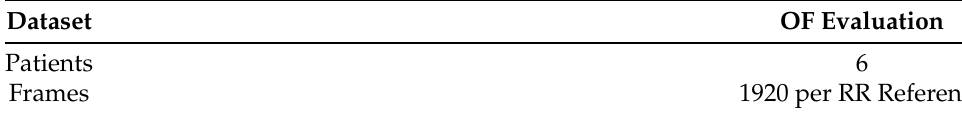
Table 2. Dataset sampling for evaluation of the OF algorithm.